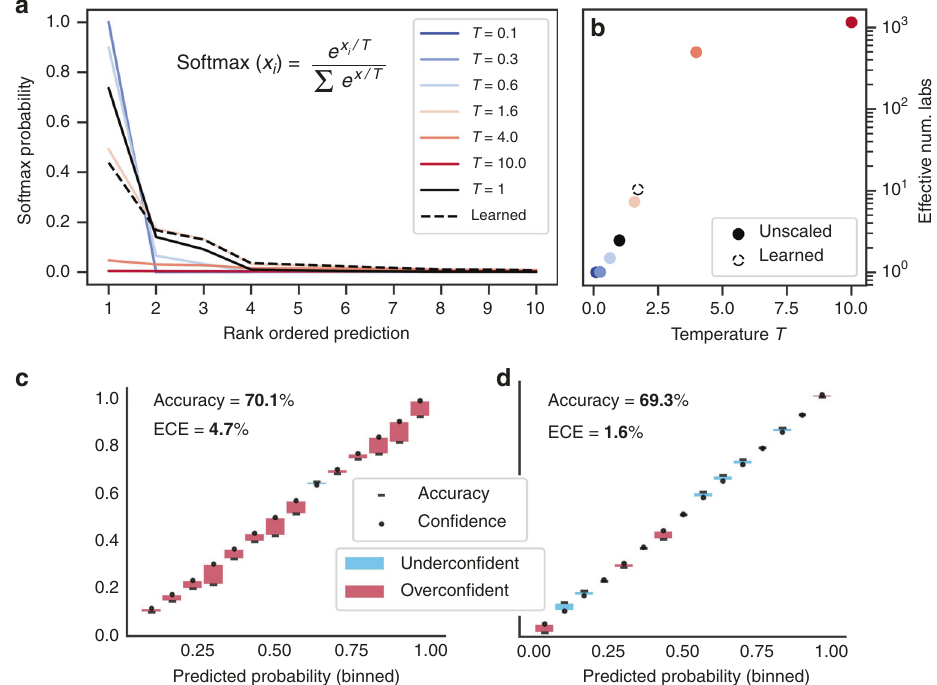
Fig. 2 Model calibration and improvement with temperature scaling. a The effect of temperature scaling on the top ten predictions of a randomly selected plasmid from the validation set ’ s predicted logits. The temperature parameter divides the class logits in the softmax, increasing (higher temperature) or decreasing (lower temperature) entropy of predictions. T = 1 corresponds to default logits without temperature scaling. b Effective number of labs, exp(entropy), for the same random example as ( a ) as a function of temperature scaling parameter T with the unscaled default in black and the value of T learned by the temperature scaling calibration procedure shown in dotted outline. c Reliability diagram, pre-calibration. Every prediction in the test set is binned by predicted probability into 15 bins ( x axis). Plotted for each bin is the model ’ s predicted probability, or the con fi dence (dot) and the percentage of the time the model was correct within that bin, or the accuracy (dash). Difference between accuracy and con fi dence is shown with a shaded bar, red indicating con fi dence > accuracy, blue indicating con fi dence < accuracy. For a perfectly calibrated model, the accuracy and con fi dence would be equal within each bin. Overall prediction accuracy across all the bins and ECE are shown. d Same as ( a ) but after temperature scaling